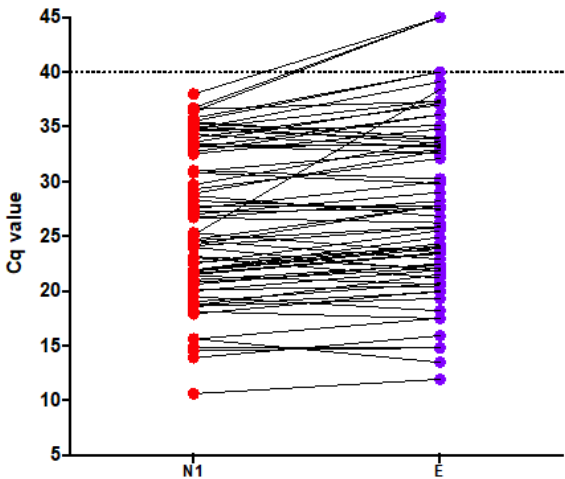
Figure 6. Cq values observed for the first 75 positive samples detected by the second version of the proposed method: N1 (red) and E (magenta). Dashed line depicts the cut-off value of >40. Three samples were positive only for N1 suggesting a better diagnostic capability for this assay.